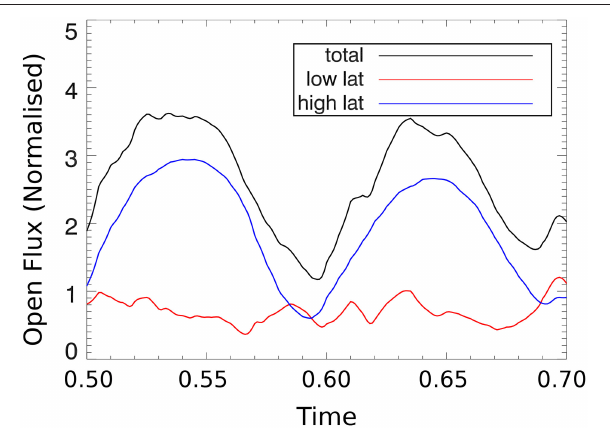
FIGURE 9 | Open magnetic flux as function of time for the two half magnetic cycle. The black line shows the total open flux measured at the source-surface (at 2.5 R ⊙ ), while the blue and red lines represent high and low latitude open flux (beyond or within ± 45 ◦ ). The high latitude open flux anti-correlates with the sunspot cycle phase, and dominates the total flux throughout most of the cycle.